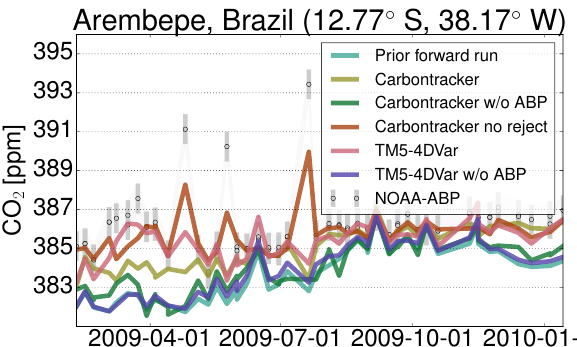
Figure 10. Time series of CO 2 concentration in Arembepe, Brazil. The two “without ABP” runs show the concentrations when the models do not assimilate data from the Arembepe site. Carbon- Tracker noreject shows the concentrations for CarbonTracker with disabled outlier rejection. The time series ends after January 2010 because data at Arembepe are only available in obspack PROTO- TYPE v1.0.2 2013-01-28 from NOAA Environmental Sciences Di- vision and Oak Ridge National Laboratory (2013) until that